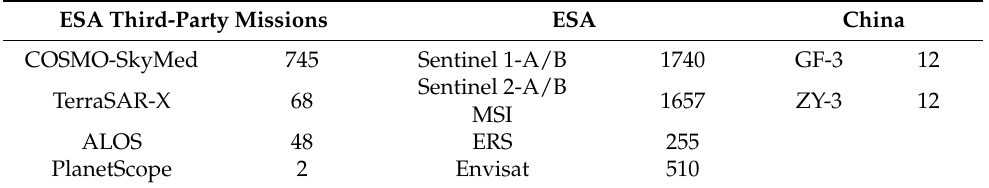
Table 1. Earth Observation (EO) data used in this work (Mission/Satellite | Number of images). ESA Third-Party Missions ESA China COSMO-SkyMed 745 Sentinel 1-A/B 1740 GF-3 TerraSAR-X